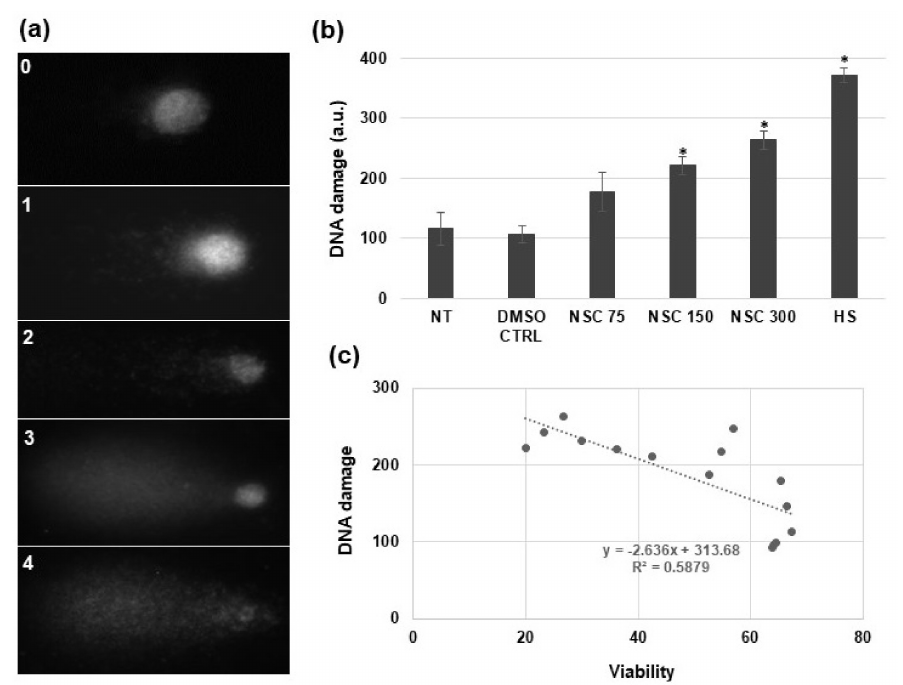
Figure 2. DNA damage induced by NSC120686 treatment in M. truncatula wild-type calli as assessed by alkaline single cell gel electrophoresis (SCGE) assay. ( a ) Nuclear morphology of the different comet classes; ( b ) Level of DNA damage (represented in a.u.) measured upon treatment with increasing NSC120686 concentrations (75 µ M, 150 µ M, and 300 µ M). ( c ) Correlation analysis between the levels